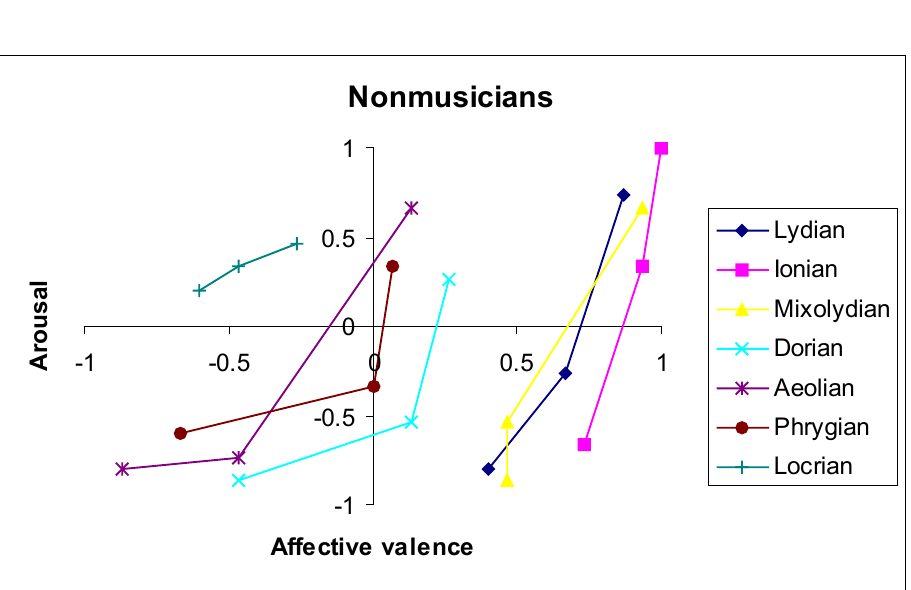
Figure 1. Arousal and affective valence of emotional responses to the modal excerpts (Lydian, Ionian, Mixolydian, Dorian, Aeolian, Phrygian, and Locrian) by nonmusicians and musicians. The three levels of each upward line indicate the three tempi employed: 72, 114, and 184 beats per